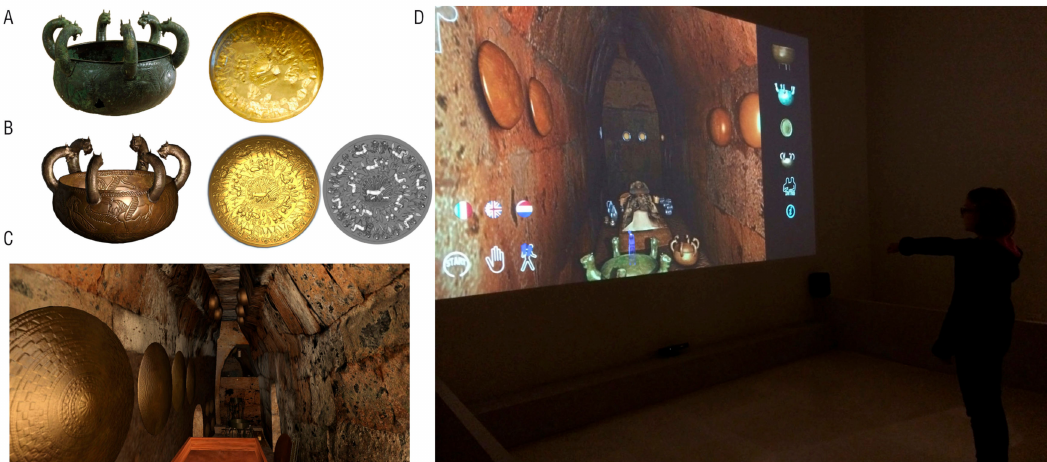
Figure 6. Virtual reconstruction of the Regolini Galassi tomb and virtual restoration of some objects of the funerary goods. ( A ) archaeological artefacts; ( B ) virtual restoration; ( C ) virtual reconstruction of the tomb; ( D ) museum installation. CNR Institute of Technologies Applied to The Cultural Heritage, Visual Dimension, Vatican Museums,